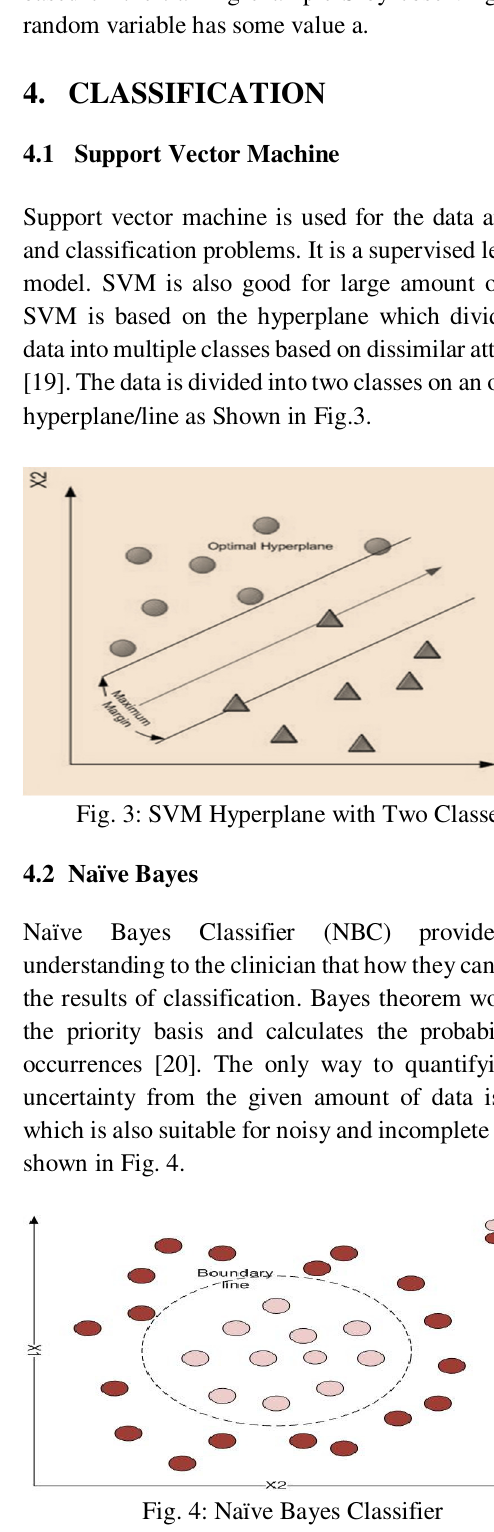
Fig. 4: Naïve Bayes